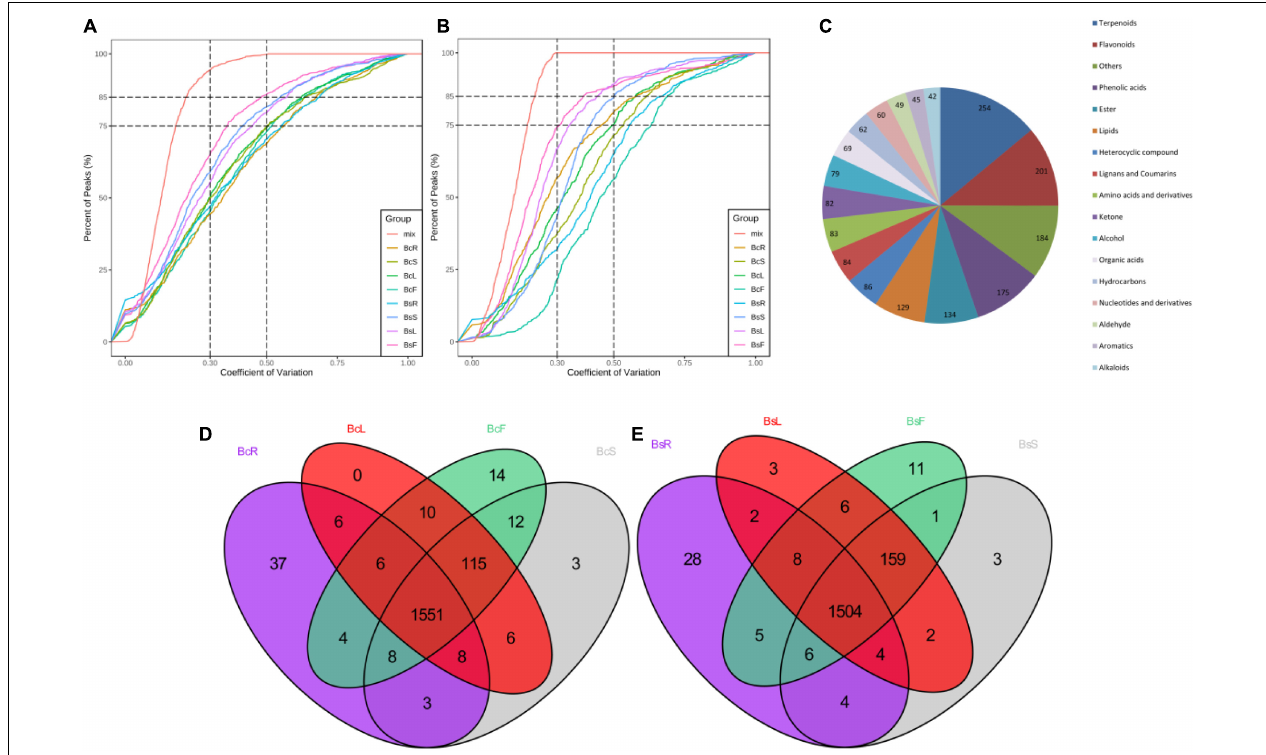
FIGURE 2 | Quality control (QC) sample with the coefficient of variation (CV) of LC-MS (A) and GC-MS (B) less than 0.3 accounted for more than 75% of the samples, indicating that the experimental data were very stable. Overview of annotated metabolites (C) . Venn diagram of the detected metabolites in four tissues of Bc (D) and Bs (E)